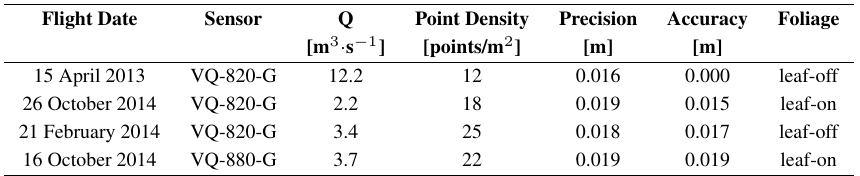
Table 2. Summary of data